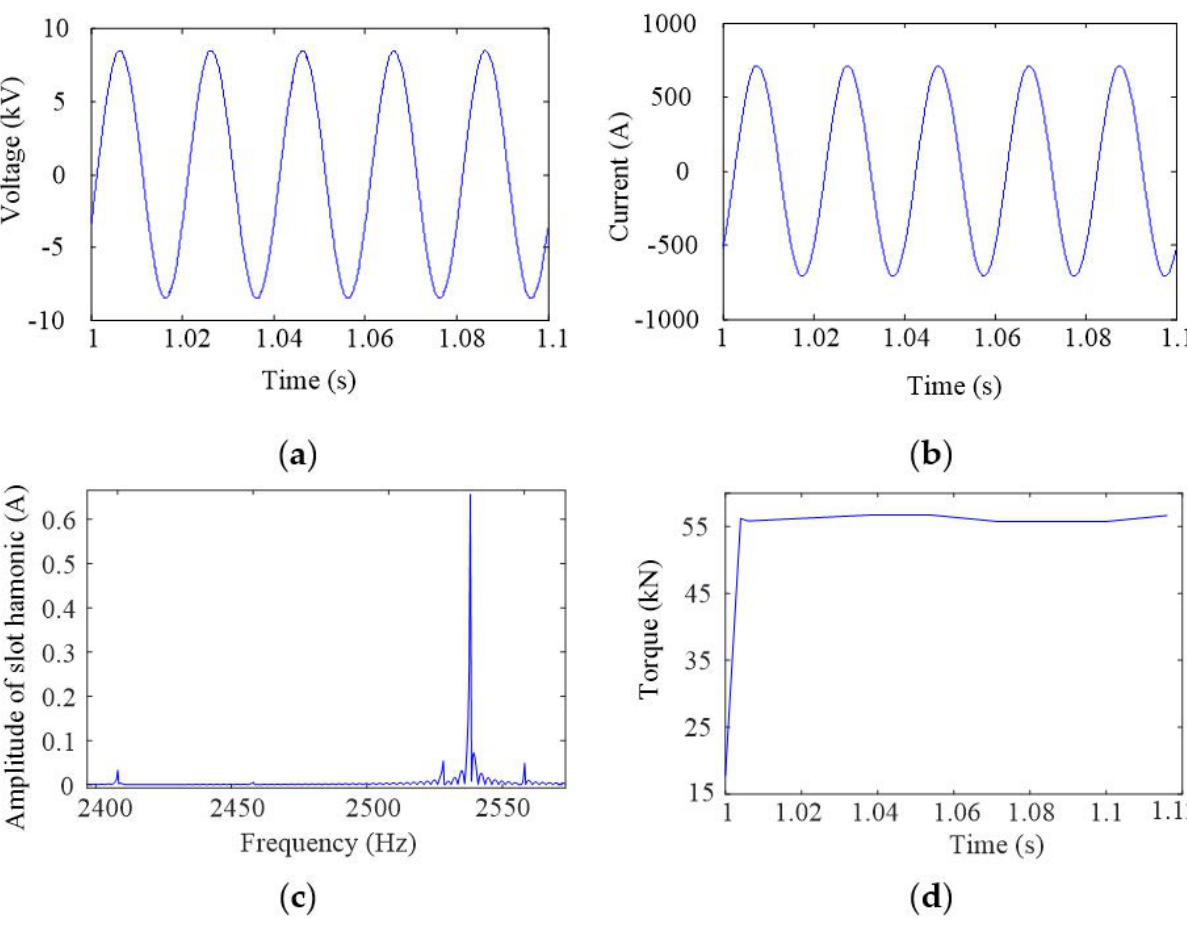
Figure 6. Measured waveforms with the developed monitoring system and estimated air-gap torque and slot harmonic obtained by the presented method. ( a ). Voltage. ( b ) Current. ( c ) Air-gap torque. ( d ) Rotor slot harmonic. Table 5. Extracted parameters by QPSO-TRA and